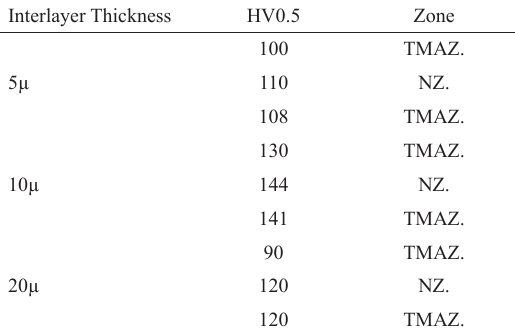
Table 6: Microhardness results of Al7020 alloy joints with different Zn interlayer thickness. Interlayer Thickness